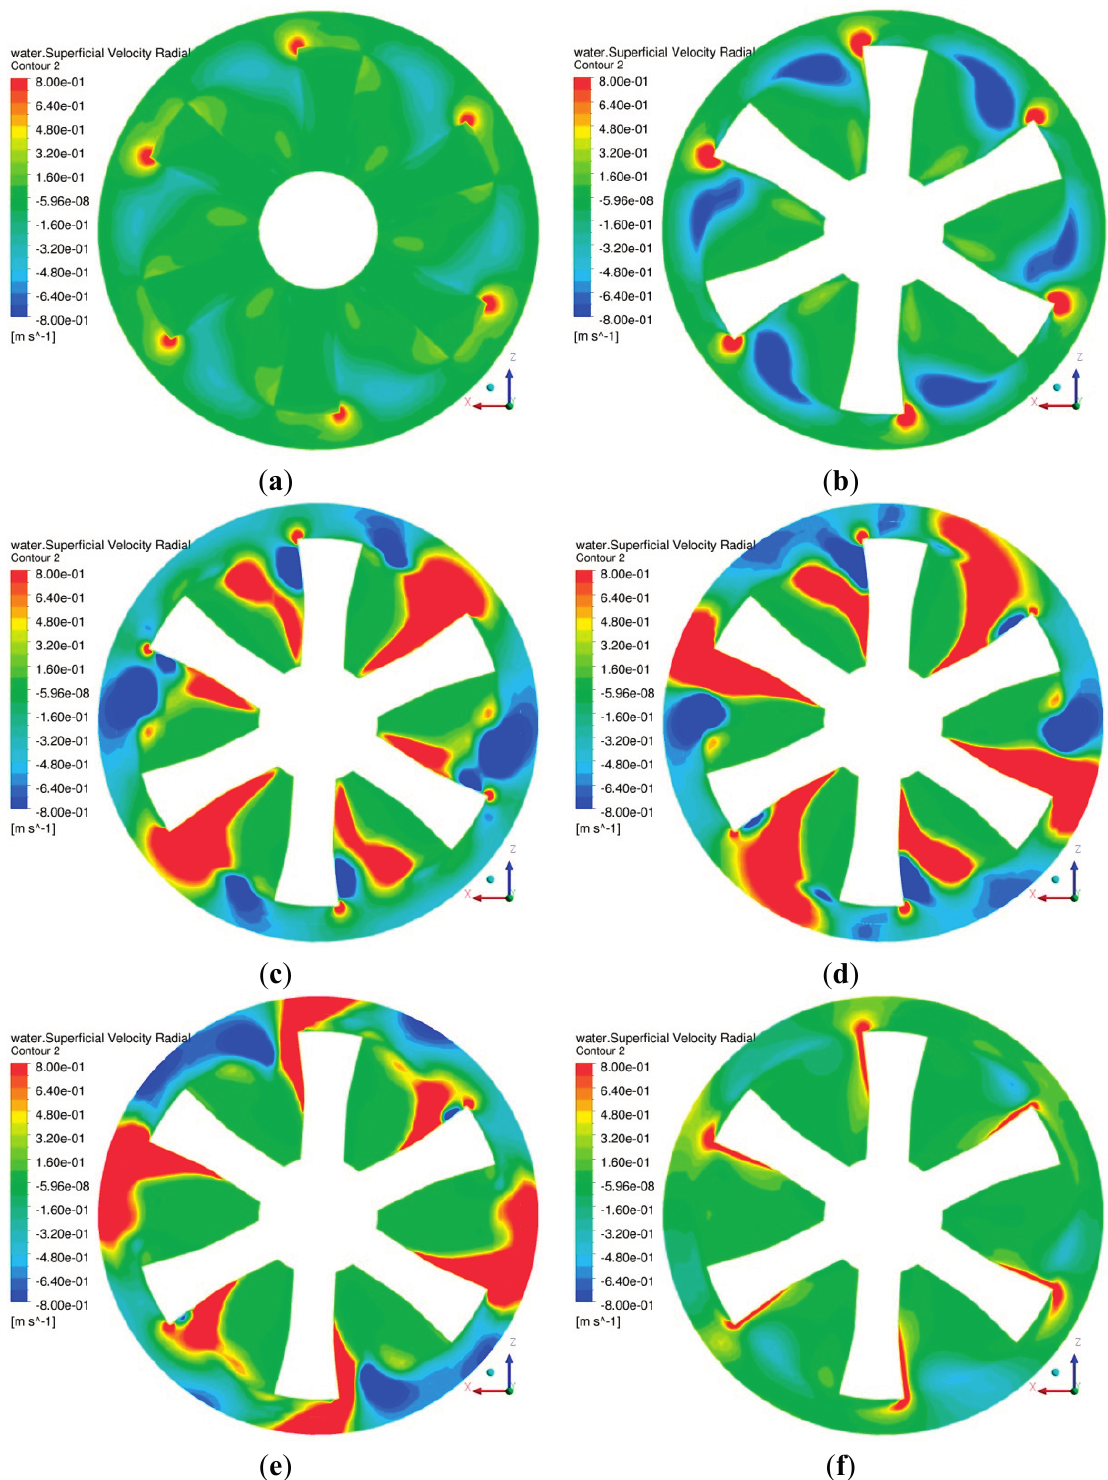
Figure 7. Water superficial radial velocity contours in horizontal planes cutting rotor blades, t = 15.4 s, d b = 0.7 mm; ( a ) y = 0.86 m; ( b ) y = 0.87 m; ( c ) y = 0.9 m; ( d ) y = 0.92 m; ( e ) y = 0.96 m; ( f ) y = 1.10